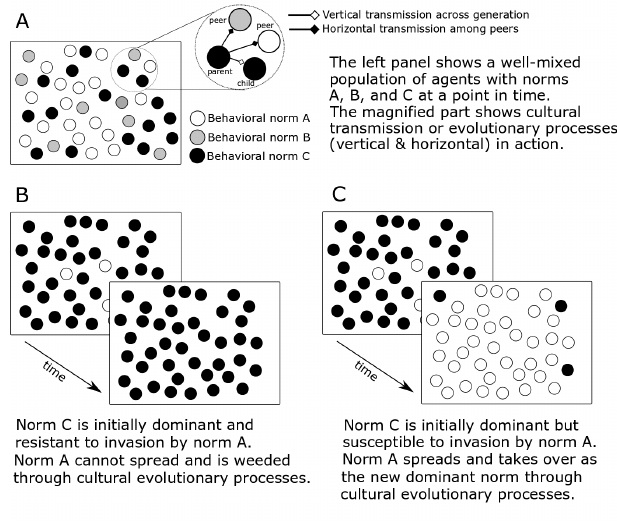
Fig. 2 . (a) Diverse cultural traits (norms A, B, and C) can exist at the level of individuals and the proportions of these traits within a social group can change over time through the processes of cultural evolution in the forms of horizontal and vertical transmissions. (b) A cultural trait (norm C) is initially dominant and remains stable, resisting invasion by a mutant trait (norm A). (c) A cultural trait (norm C) is initially dominant but is unstable, being overrun by a mutant trait (norm A).